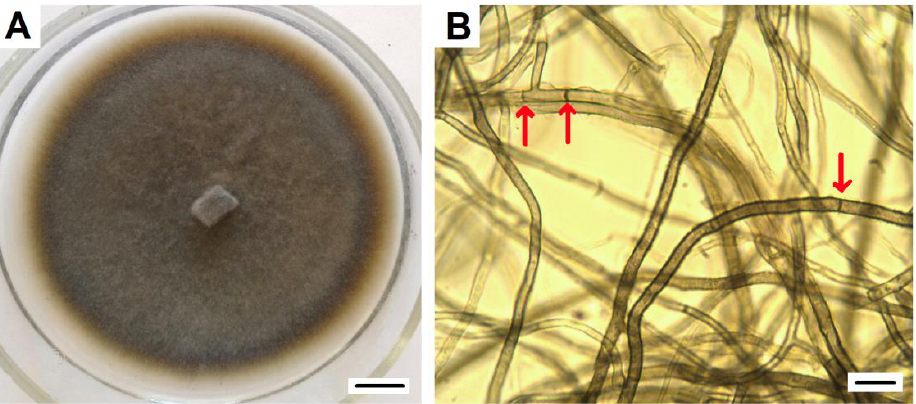
Figure 2. P. fortinii DSE2 isolate: ( A ) pure culture of P. fortinii DSE2 isolate. Colony developed from hyphal plug placed at the center of the Petri dish. Bar = 1 cm; ( B ) bright-field micrograph of P. fortinii DSE2 isolate hyphae. Arrows indicate septae. Bar = 10 µm.